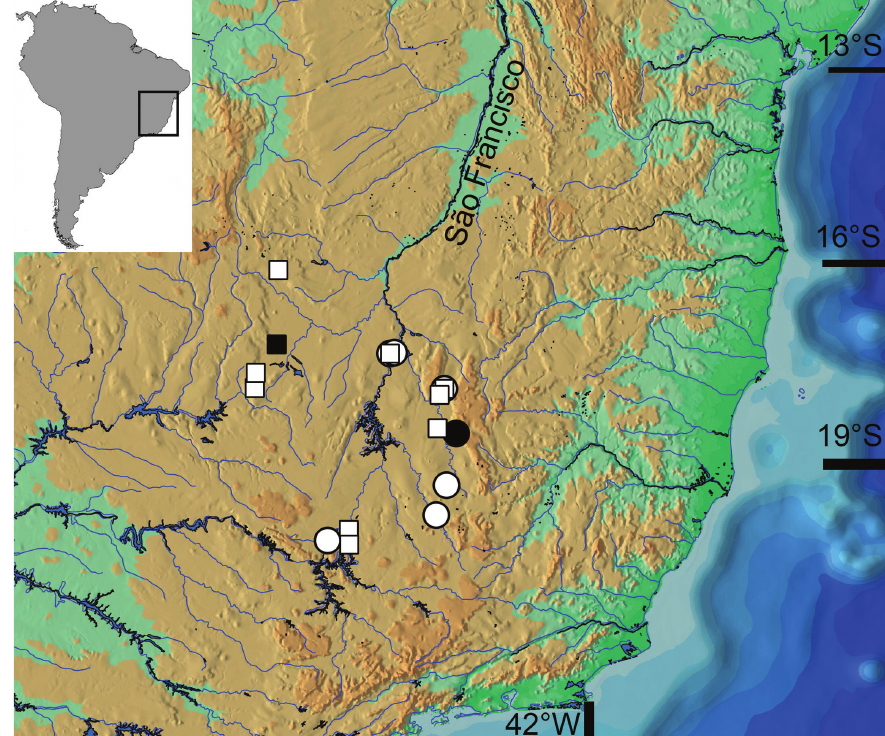
Fig. 4. Distribution map of the new species of Bunocephalus in the rio São Francisco basin, Brazil. Circles represent Bunocephalus hartti and squares represent B. minerim , solid symbols indicate the